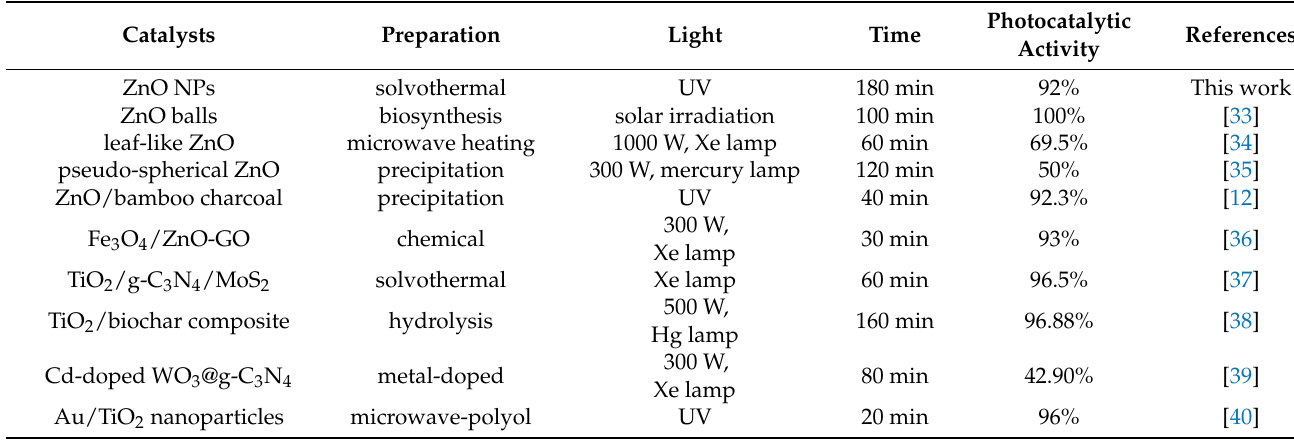
Table 3. Summary of the degradation of MO by different photocatalysts.